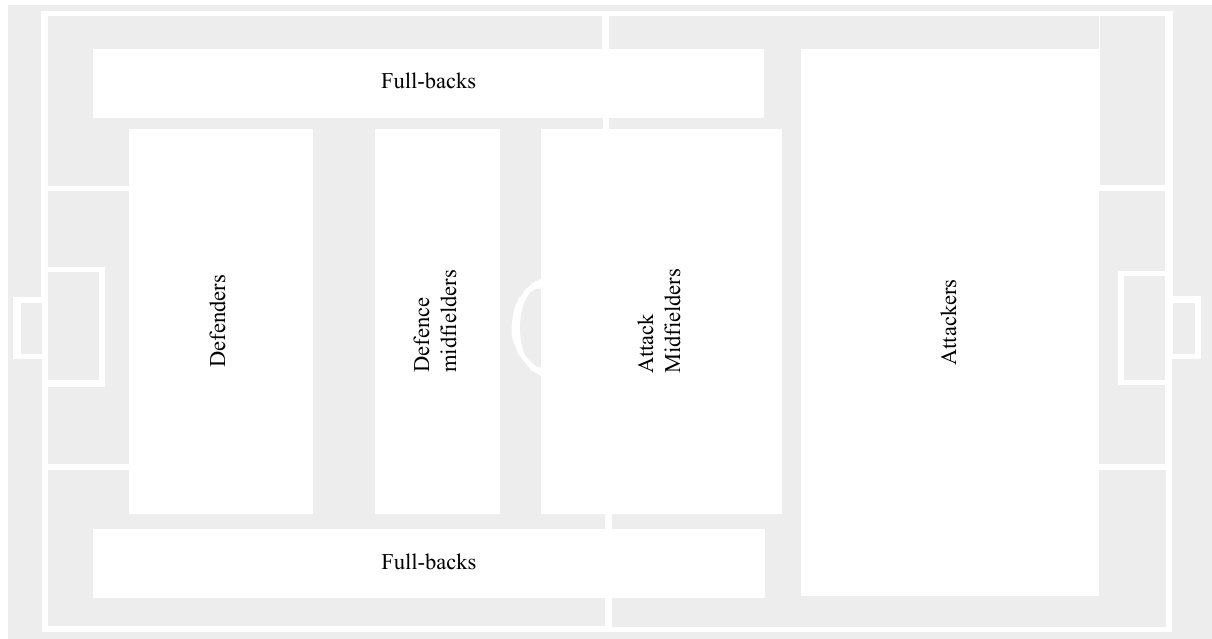
Figure 1. - Playing positions adopted in the present